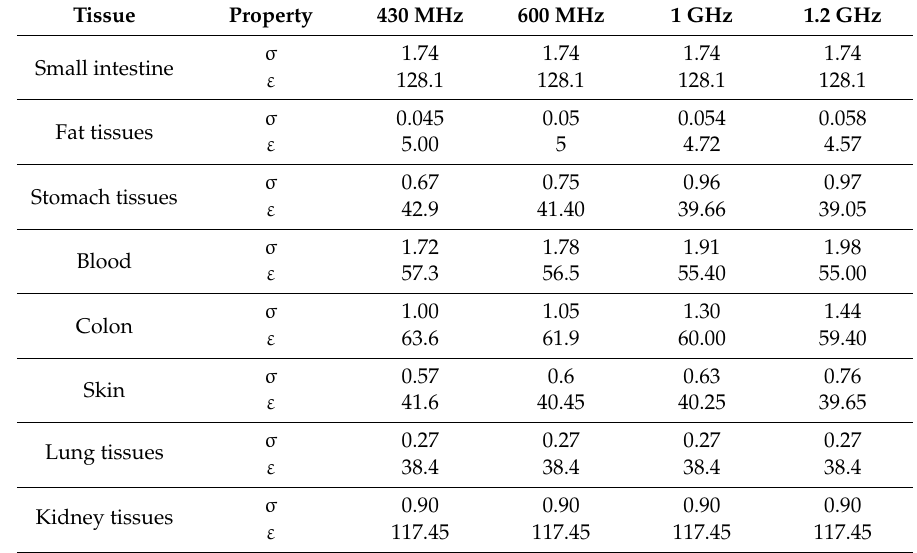
Table 5. Electrical properties of body tissues [16,17].